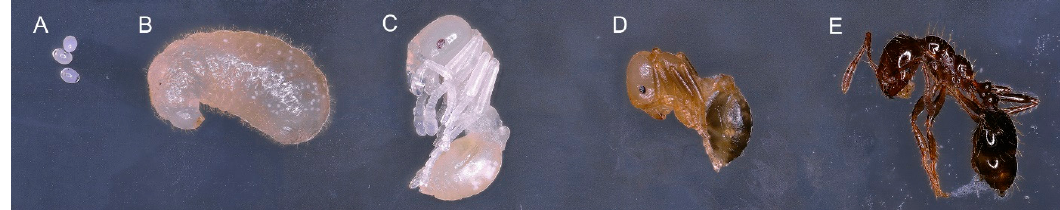
Figure 1. Developmental stages of the S. invicta worker caste: ( A ) egg; ( B ) larva; ( C ) early stage (white) pupa; ( D ) late stage pupa or pharate adult; ( E ) adult. RNA samples were extracted from representatives similar to ( B , C ).